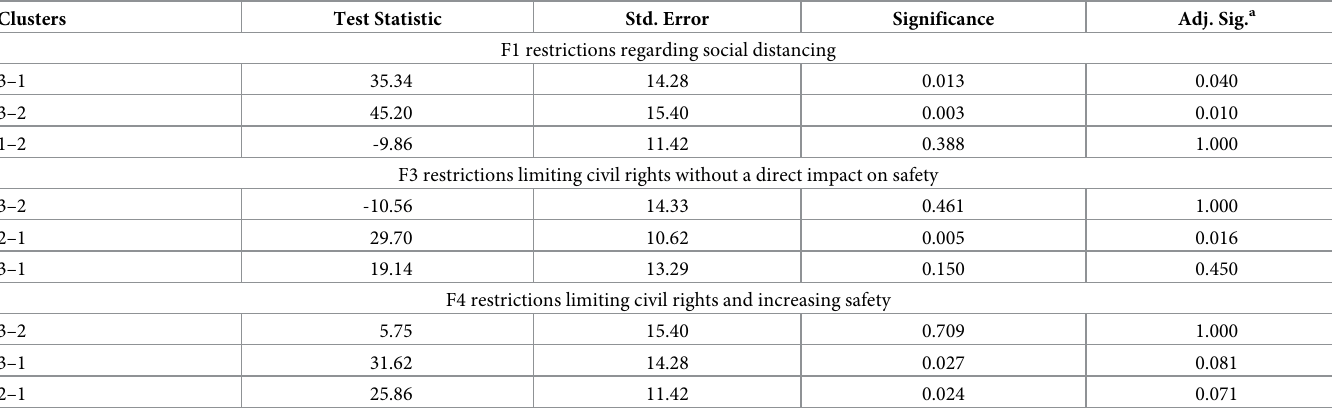
Table 6. Post-hoc pairwise multiple comparisons of the clusters after Kruskal-Wallis test. Clusters